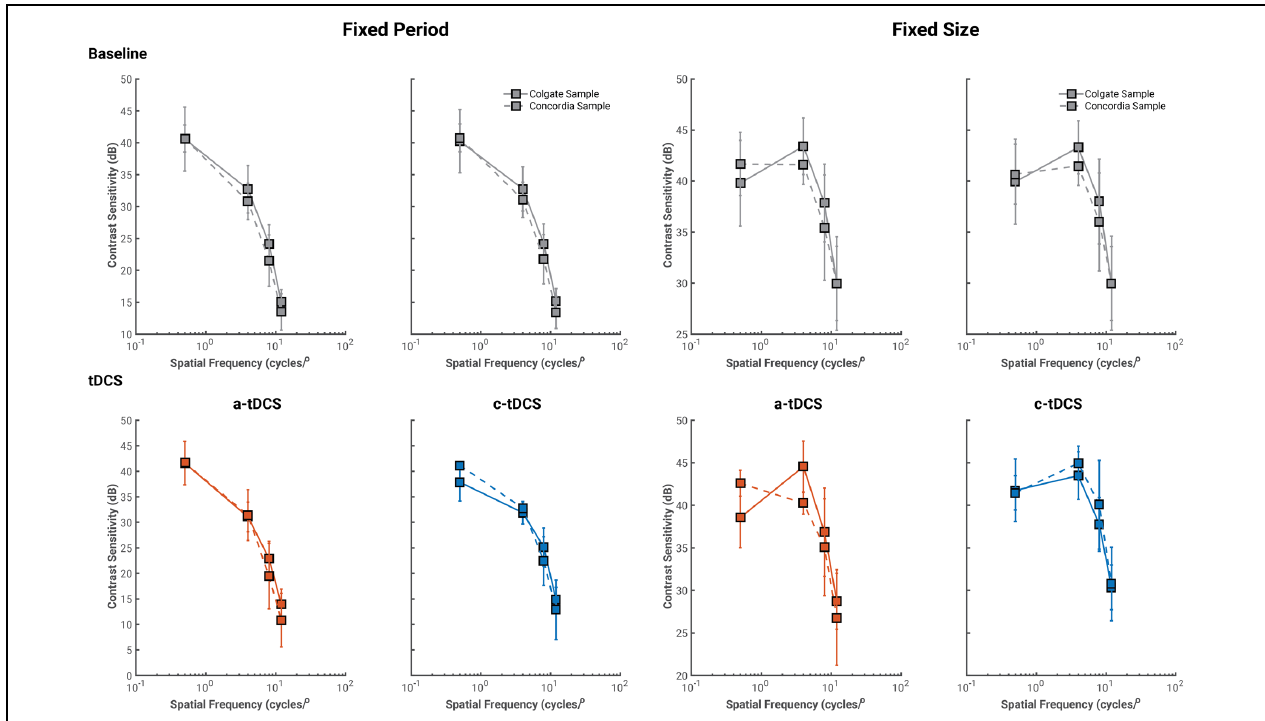
FIGURE 2 | Average contrast sensitivity values collected from the Colgate University (solid lines) and Concordia University (dashed lines) at baseline (gray) and tDCS sessions. For all conditions, contrast sensitivity values from both samples overlapped significantly and thus, were averaged for all subsequent